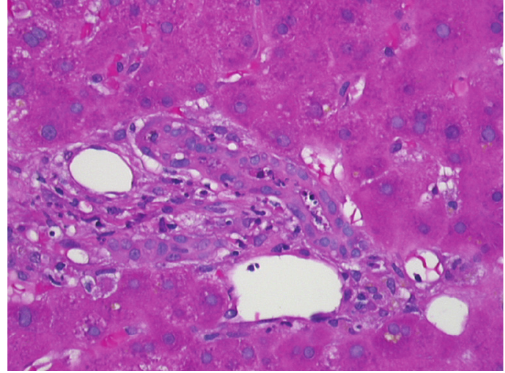
Figure 6: Allograft (40x, H&E